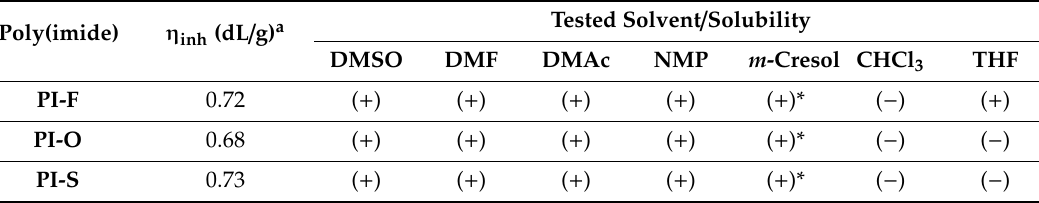
Table 2. Solubility and inherent viscosities of poly(imides).